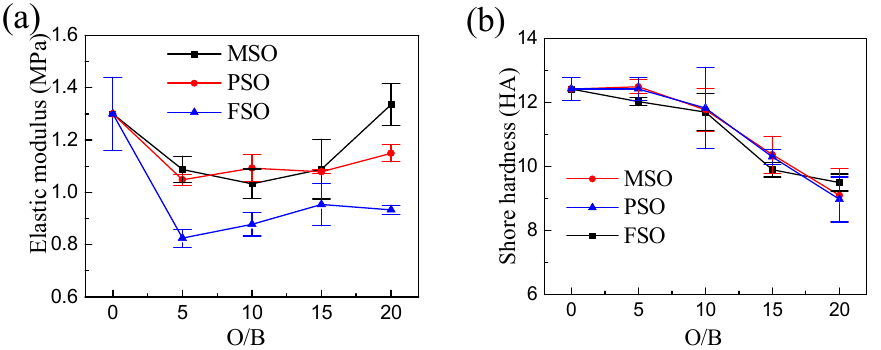
Figure 11. Mechanical properties of coatings change with O/B in the coatings of different silicone oils: ( a ) elastic modulus, ( b ) hardness.